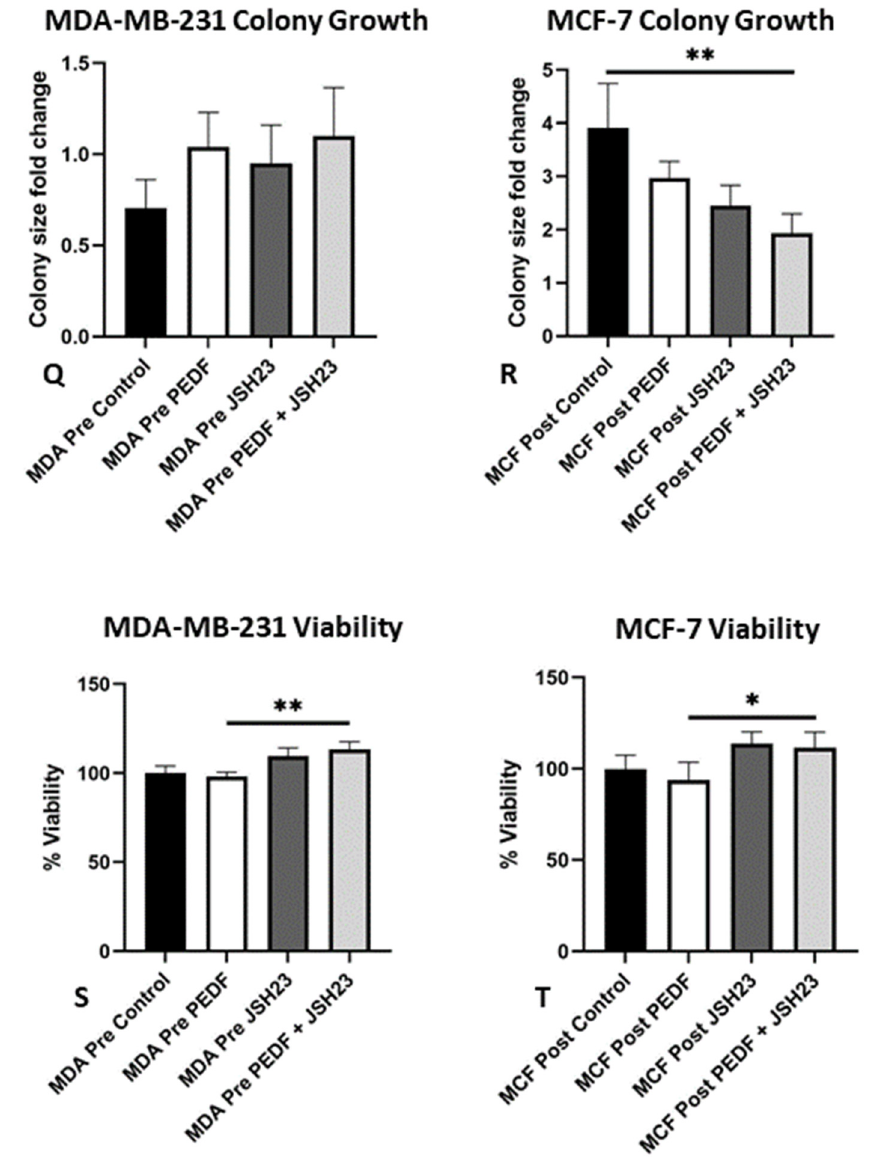
Figure 4. Functional assays in MCF-7 and MDA-MB-231 following PEDF and/or JSH-23 treatment in pre- versus post-menopausal conditions. Cells were incubated in media supplemented with pre- (E1: 258 pM; E1S: 4130 pM; E2: 271 pM) or post-menopausal (E1: 72 pM; E1S: 541 pM; E2: 14.6 pM) oestrogen levels and treated with PEDF (100 nM), JSH-23 (20 µM), combined PEDF (100 nM) + JSH- 23 (20 µM), or control for 5 days for colony formation assays and for 24 h for viability assays. Fold change in colony size compared to day 1 replicates was calculated for MDA-MB-231 under pre- menopausal conditions and MCF-7 under post-menopausal conditions. Microscope images of MDA-MB-231 colonies at day 1 under pre-menopausal conditions treated with control ( A ), PEDF ( E ), JSH-23 ( I ), or PEDF + JSH-23 ( M ) and at day 5 treated with control ( B ), PEDF ( F ), JSH-23 ( J ), or PEDF + JSH-23 ( N ), and MCF-7 colonies under post-menopausal conditions at day 1, treated with control ( C ), PEDF ( G ), JSH-23 ( K ), or PEDF + JSH-23 ( O ) and at day 5 treated with control ( D ), PEDF ( H ), JSH-23 ( L ), or PEDF + JSH-23 ( P ). Graphs showing fold change colony growth following 5 days treatment for MDA-MB-231 cells under pre-menopausal conditions ( Q ) and MCF-7 cells under post- menopausal conditions ( R ). CellTitre Blue assay was used to determine viability of MDA-MB-231 under pre-menopausal conditions ( S ) and MCF-7 under post-menopausal conditions ( T ). Scale bar 50 µM. ** p = 0.001–0.009; * p = 0.01–0.05.